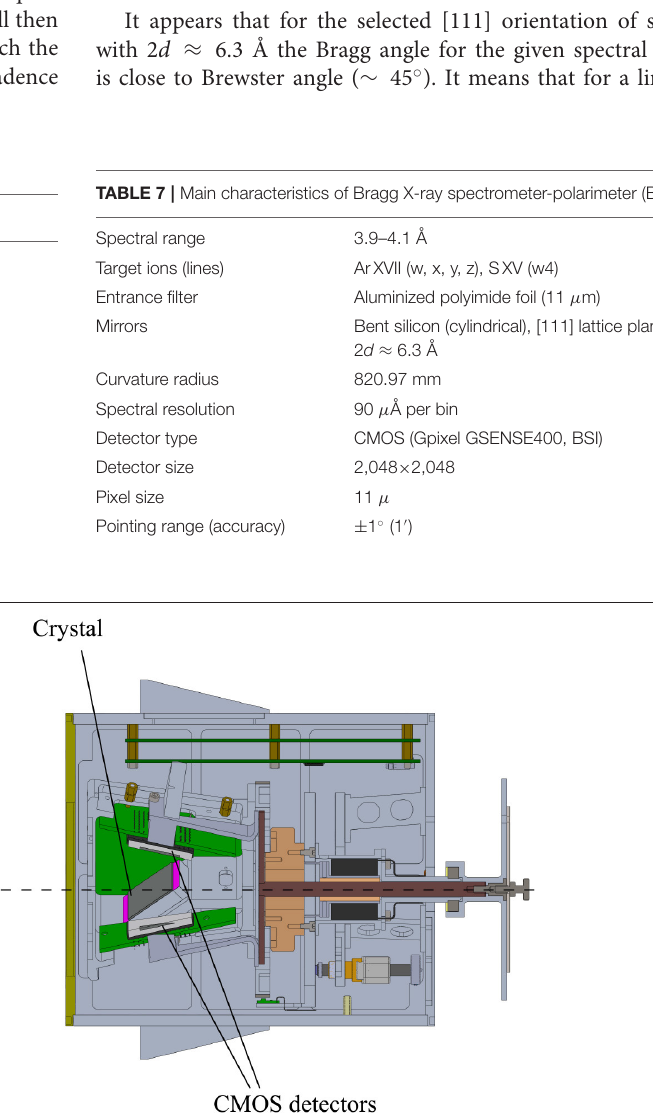
Frontiers in Astronomy and Space Sciences |